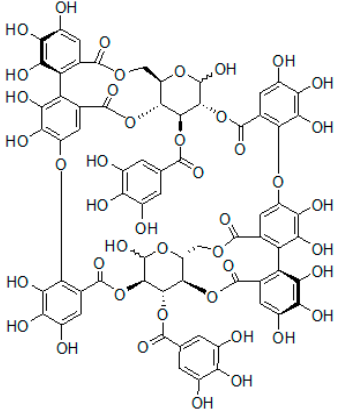
Figure 1. Structure of oenothein B.